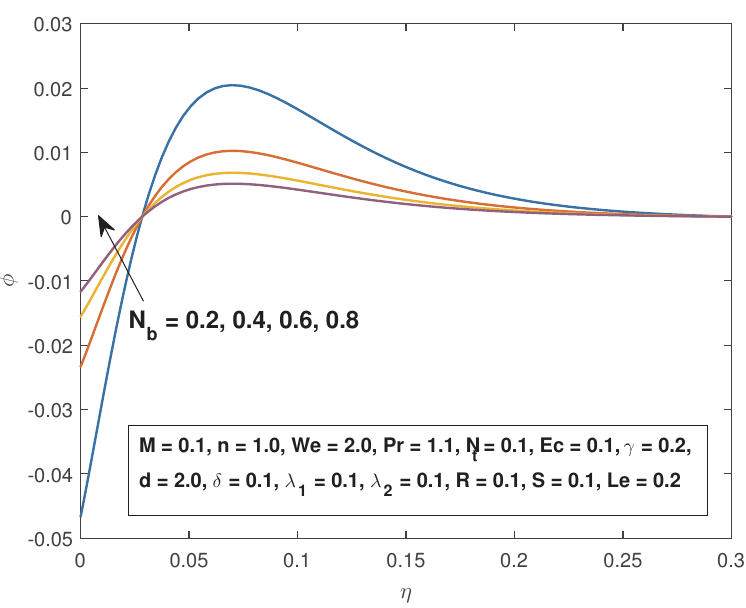
Figure 19. Influence of N b on the fluid